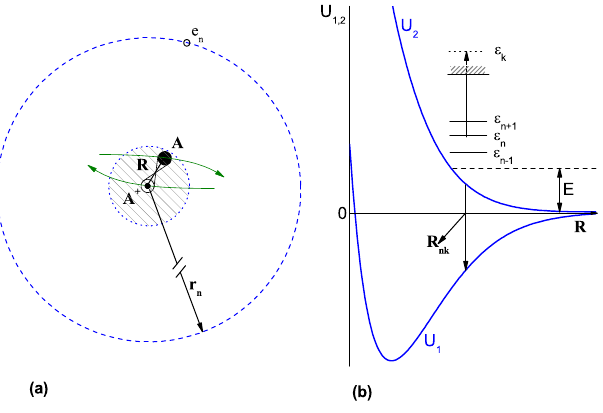
Figure 1. ( a ) schematic illustration of A ∗ ( n , l ) + A collision (1) within the domain of internuclear distances R (cid:28) r n , where r n is the characteristic radius of Rydberg atom A ∗ ( n , l ) ; ( b ) schematic illustration of the resonance